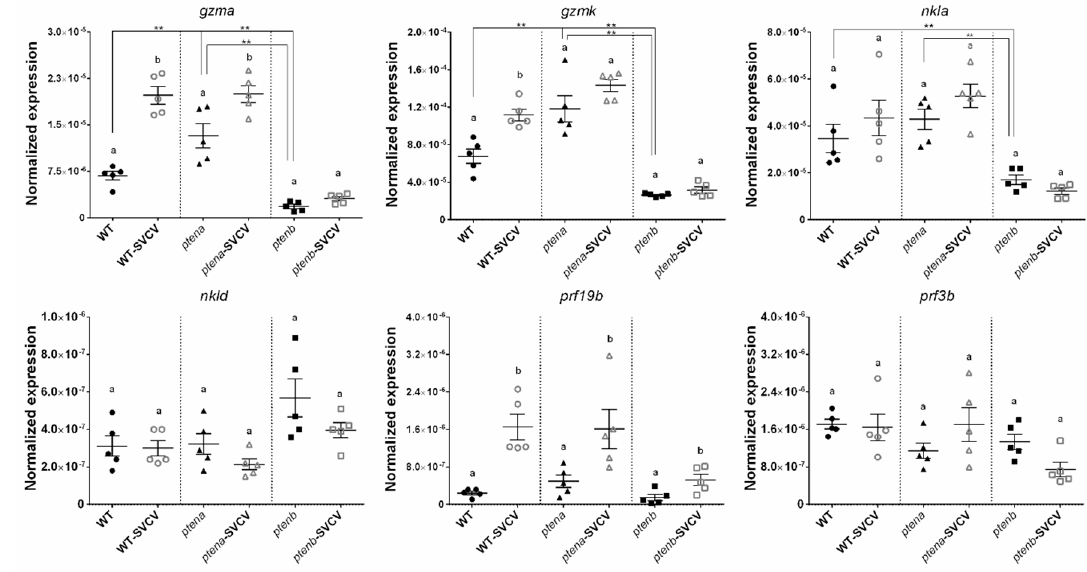
Figure 5. Expression of cytotoxic granule-related genes in WT, ptena -/- , and ptenb -/- zebrafish larvae under healthy and SVCV-infected conditions. The expression of the di ff erent genes was normalized to the expression of the 18S ribosomal RNA gene. The graphs represent the means ± SEMs of 5 biological replicates. Statistically significant di ff erences between the uninfected and SVCV-infected individuals from the same zebrafish line are represented with di ff erent letters, whereas di ff erences among the zebrafish lines are represented with asterisks as follows: ** (0.001 < p < 0.01).